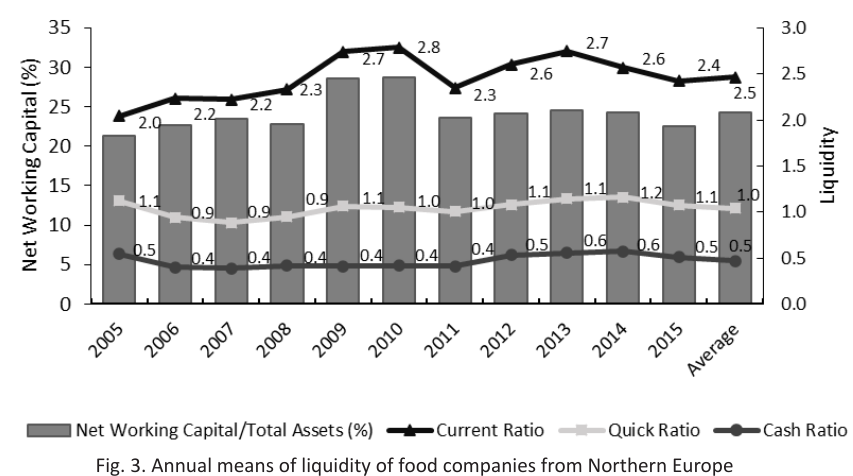
Fig. 3. Annual means of liquidity of food companies from Northern Europe